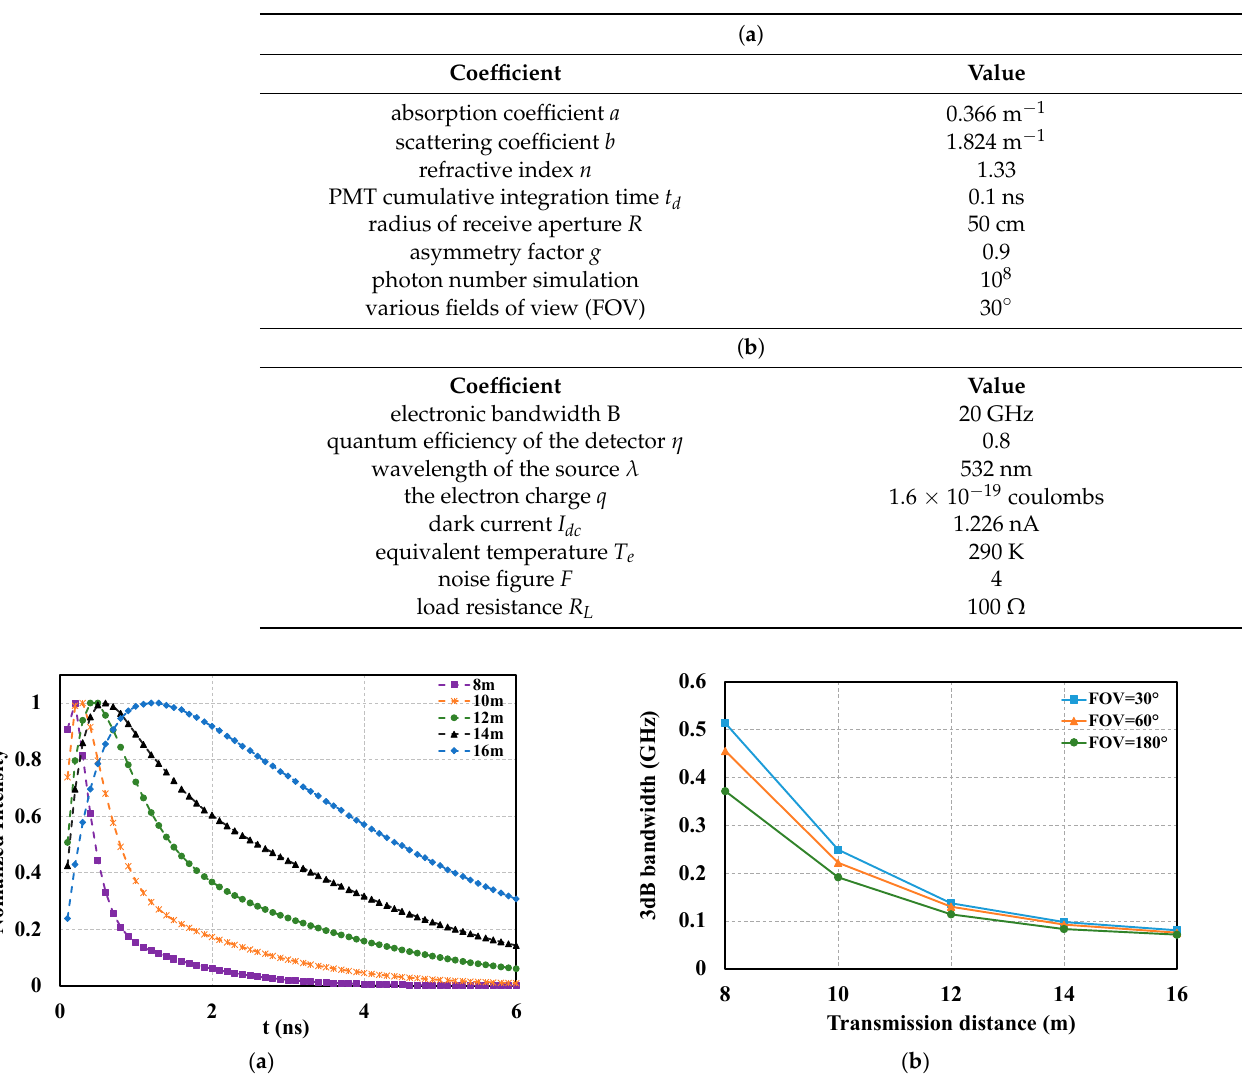
Table 1. ( a ) Parameter settings for Monte Carlo simulation [14]. ( b ) Parameter settings for the noise model [34].